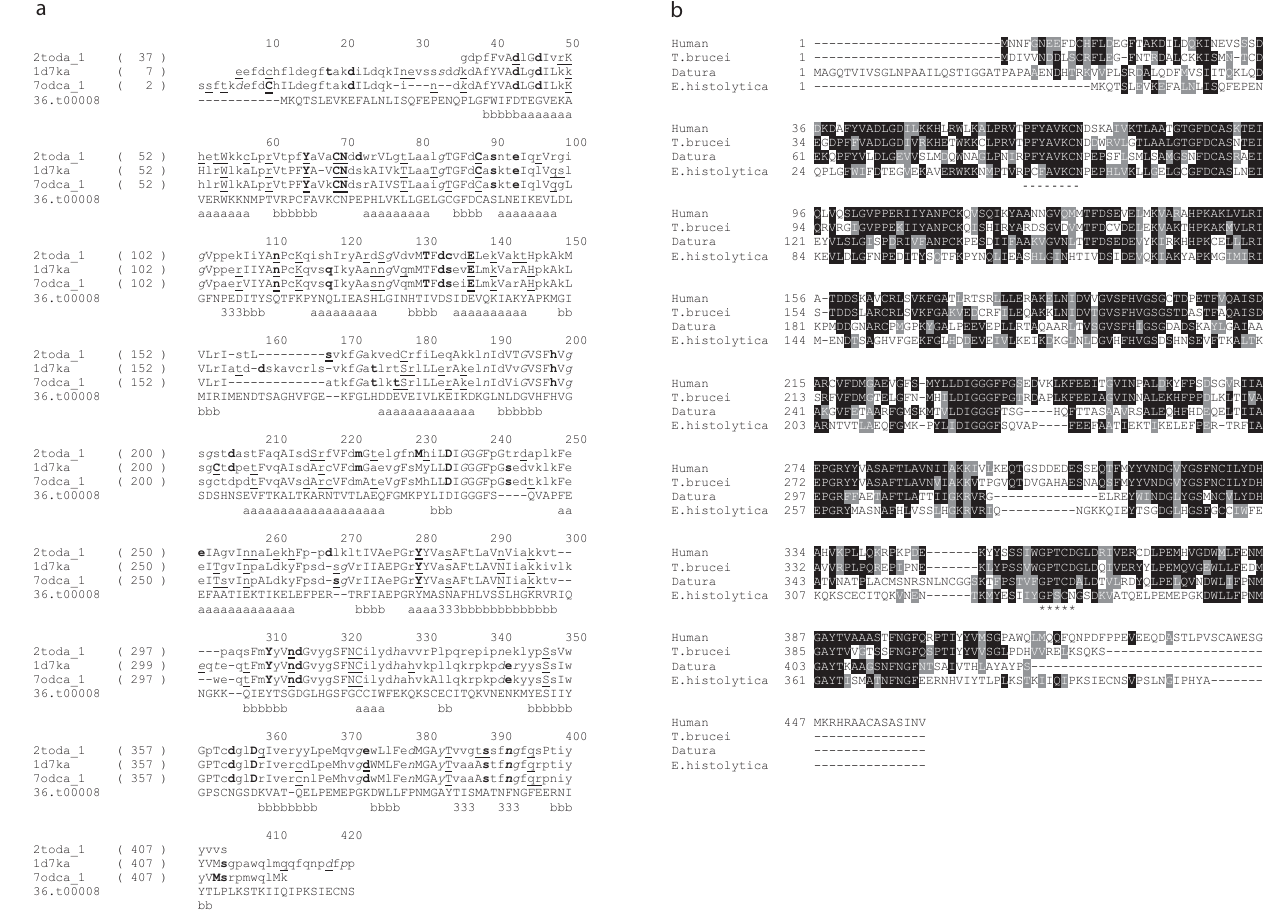
Figure 1. Structure-based alignment of ODCs from T.brucei (2toda) (ExPASy accession number: P07805), H.sapiens (1d7ka) (ExPASy accession number: P11926), M.musculus (7odca) (ExPASy accession number: P00860), and E.histolytica (36.t00008) (GenBank accession number: Q58P26). (A) The structural environments of the residues in the known structures are encoded in the representation: Upper case letters are solvent-inaccessible amino acids; lower case letters are solvent accessible; italicized letters are residues with a positive w (one of the Ramachandran angles); bold letters indicate a side chain hydrogen bonded to the main chain amide; underlined letters indicate a side chain hydrogen bonded to the main chain carbonyl. The numbers within parenthesis represent the first residue of the given protein in a block. Conserved a -helical, 3 10 helical, and b -strand regions are indicated at the end of every alignment block as a, 3, and b respectively. Figure produced using JOY [34]. (B) Multiple sequence alignment of putative ODC-like sequence from E. histolytica (GenBank accession number AAX35675), T. brucei ODC (GenBank accession number AAA30219), human ODC (GenBank accession number AAA59967), and Datura stramonium ODC (GenBank accession number CAA61121) using ClustalW. The amino acids are numbered to the left of the respective sequences. Residues that are identical or similar to other ODCs are indicated in black showing complete identity, and grey when they are conserved in at least three sequences. Short dashed line below the sequence represents the pyridoxal phosphate binding site. Line of asterisks (*) represents the DFMO binding